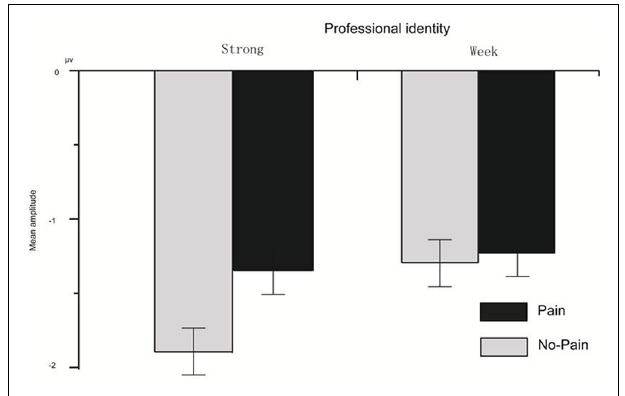
FIGURE 2 | Interaction effect of professional identity and pain empathy for the N110 component.